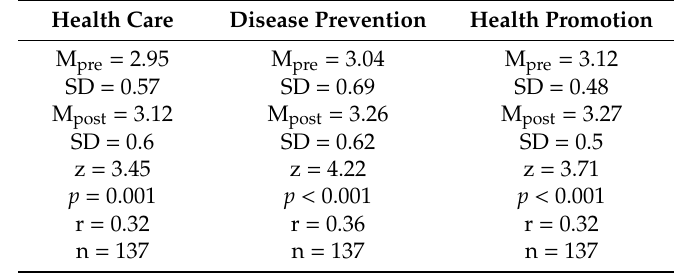
Table 2. Results of the three health domains of health care, disease prevention and health promotion.